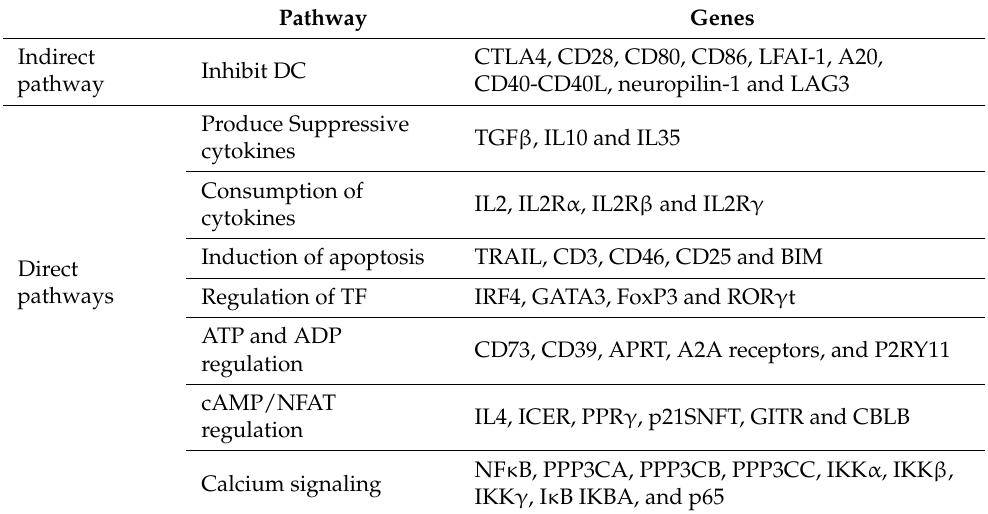
Table 1. Identified suppression mechanisms utilized by Tregs.